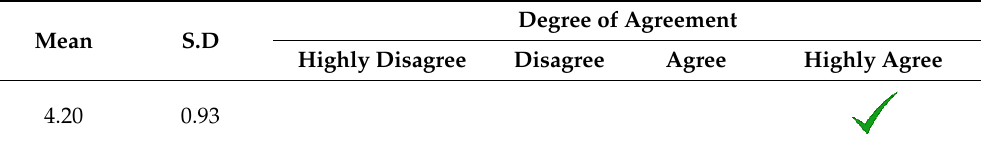
Table 3. Responses to Question 1-a.